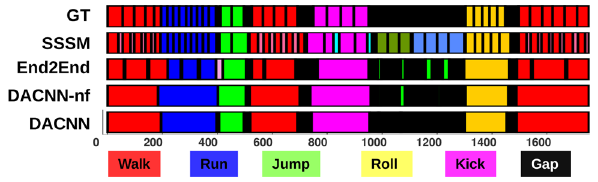
Fig. 8 Segmentation results on the CMU dataset (Subject 86, trial 03). GT ground truth segments. DACNN-nf DACNN framework with- out the fine-prediction